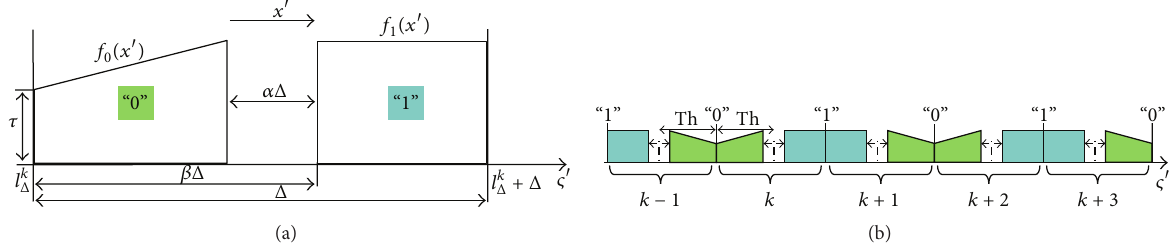
Figure 1: Distribution of the quantized coefficients: (a) Inside 𝑘 th embedding interval. (b) In five consecutive